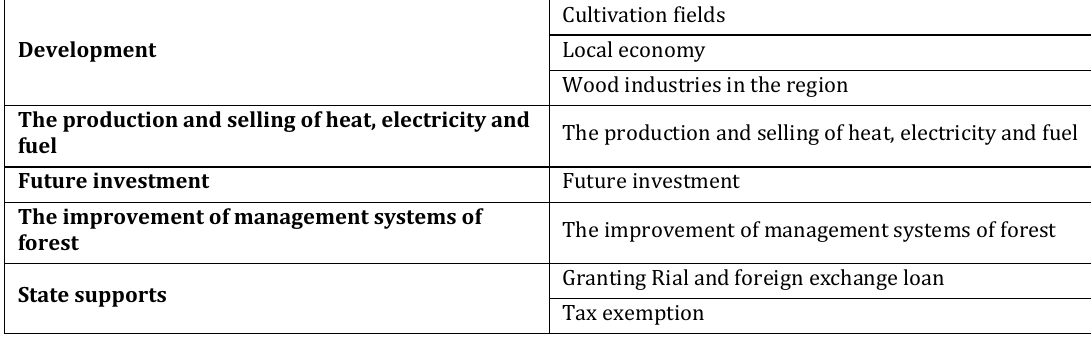
Table 6: The main criterion of the risks for site selection of new energies production from cellulosic materials